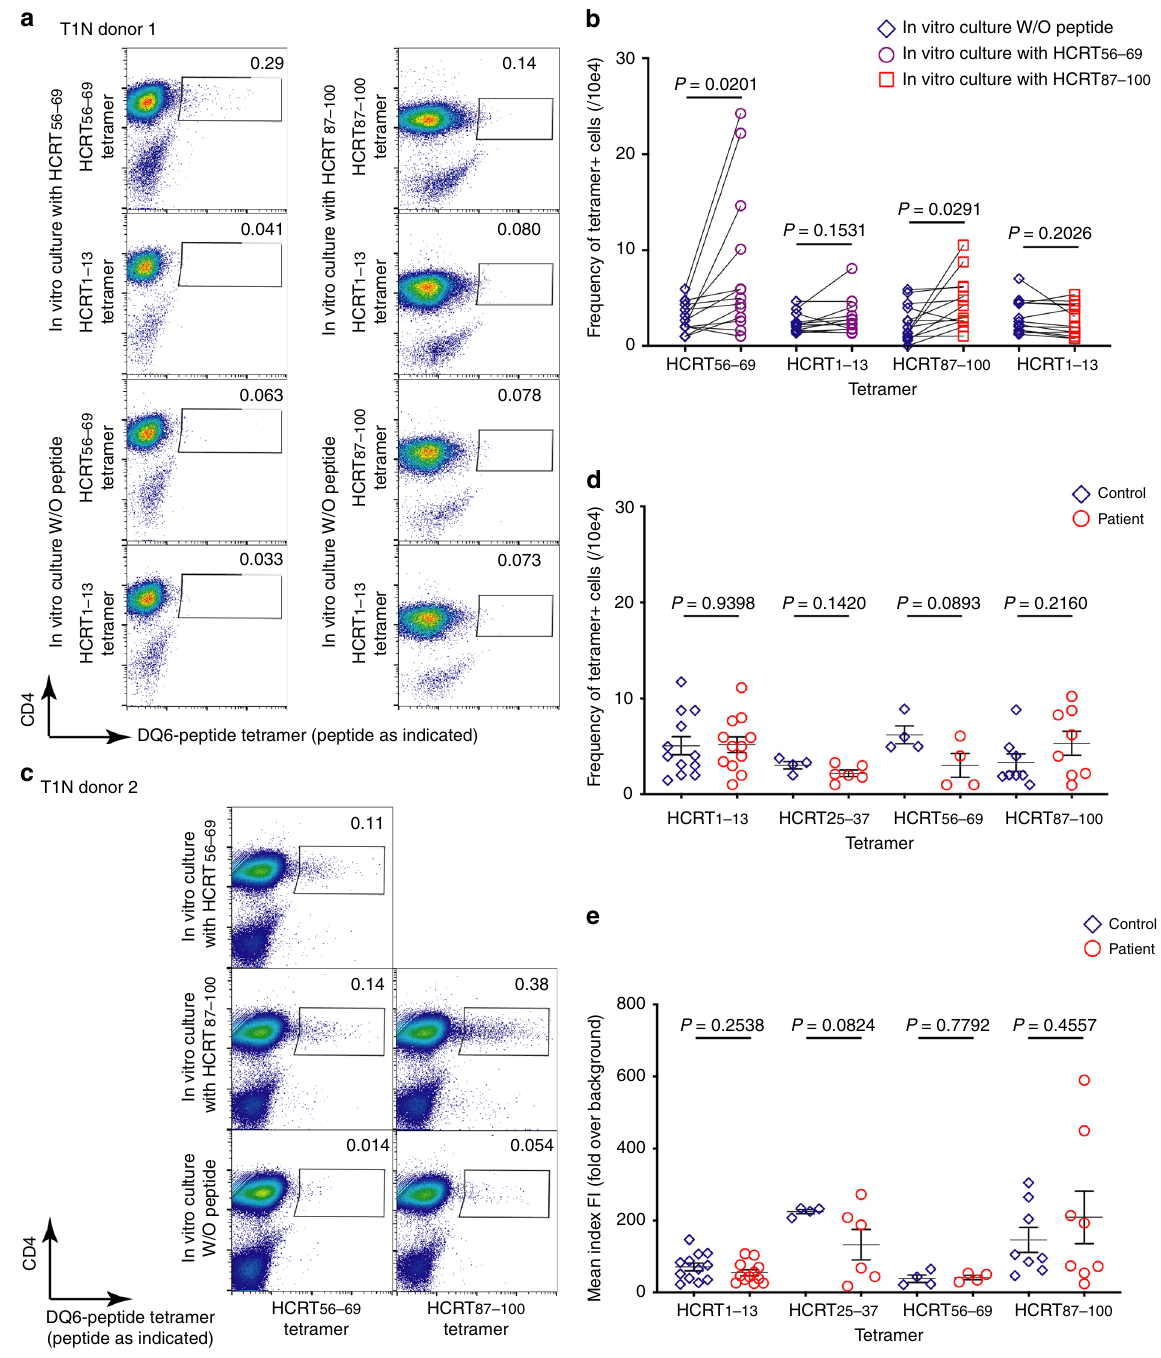
Fig. 3 Tetramer + /CD4 + T cells in DQ6 + donors. a Dot-plots of CD4 + T cells stimulated in vitro with the indicated peptides followed by staining with the indicated tetramers. Frequencies (%) of tetramer + /CD4 + T cells are indicated. b Comparison between frequencies of tetramer + T cells from the same T1N donor (paired as indicated) with and without peptide stimulation. Signi fi cance ( P < 0.05, bolded) is determined using the paired samples t -test ( n = 13 donors). c Enrichment (with peptide stimulation vs. without) of DQ6-HCRT 56 – 69 tetramer + /CD4 + T cells in HCRT 87 – 100 peptide stimulated culture. d Frequencies or e tetramer-binding ranks (mean index fl uorescence intensity) of tetramer + T cells from patients and controls (sample information summarized in Table 1) stained with the indicated tetramers. Statistical analysis compares control and patient samples within each tetramer speci fi city. Signi fi cance ( P < 0.05, bolded) is determined using the unequal variance t -test. The error bar represents mean ±